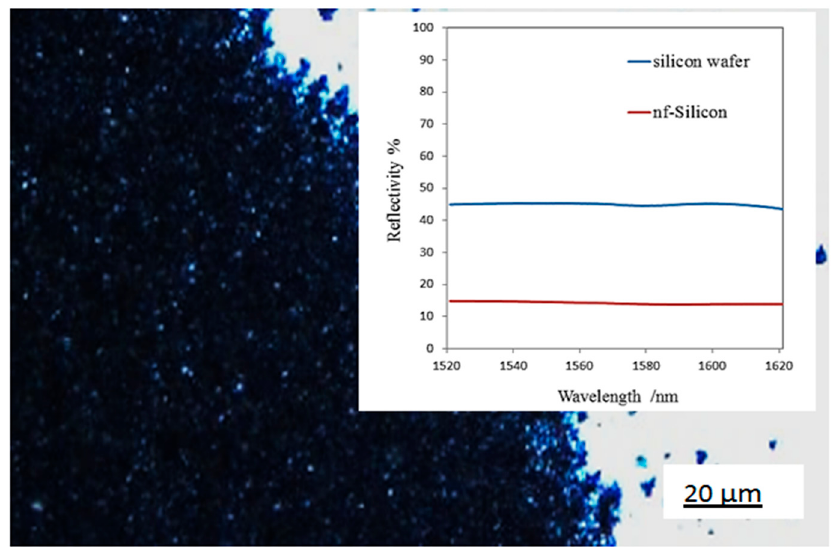
Figure 11. Optical microscope image of the as-etched silicon nanoflakes. Inset: reflectivity of silicon nanoflakes (nf-silicon; black) and silicon wafer surface (white surface) in the infrared region.